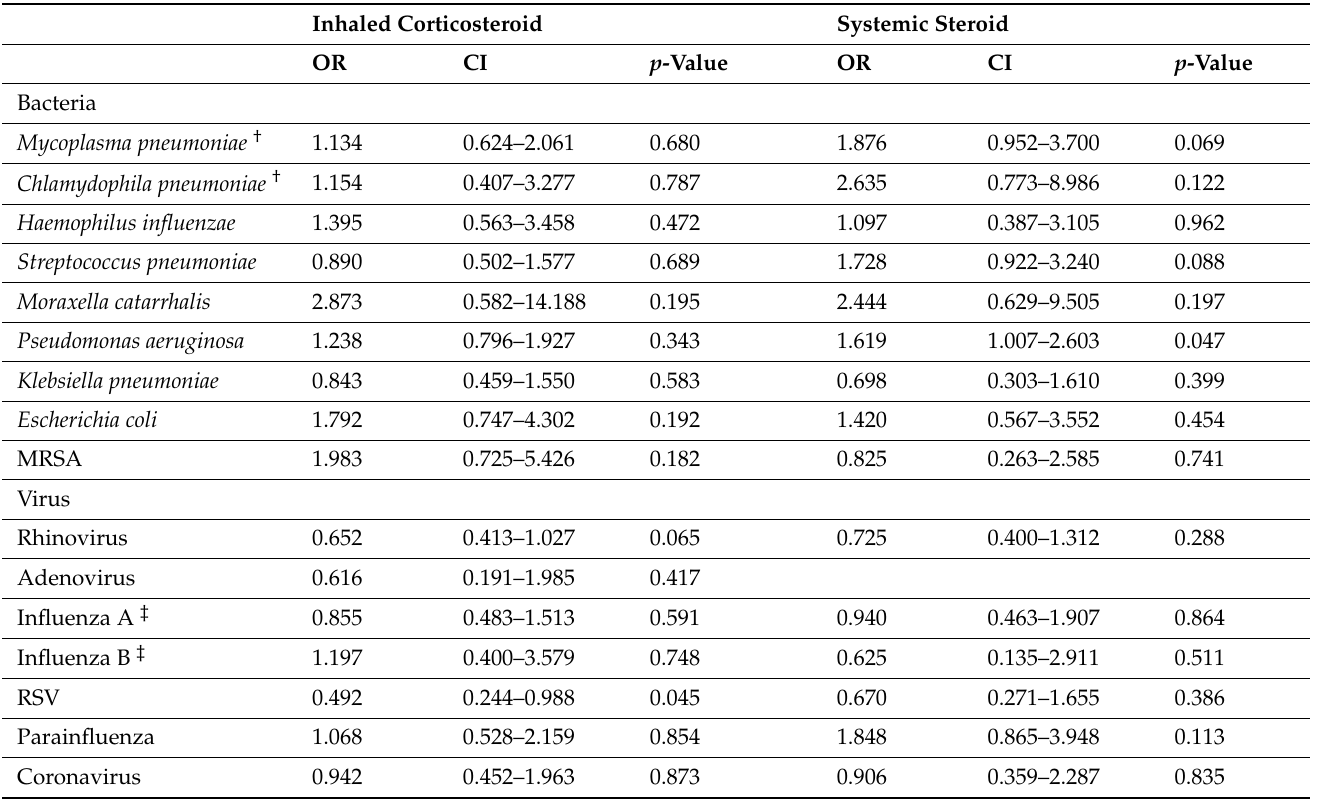
Table 2. Logistic regression analysis of the effect of inhaled corticosteroid or systemic steroid admin- istration on bacterial or viral detection during exacerbation of chronic obstructive pulmonary disease adjusted for the severity of COPD. Inhaled Corticosteroid Systemic Steroid OR CI OR